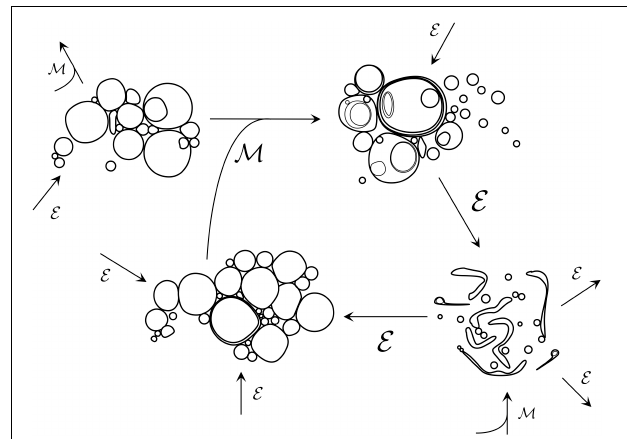
FIGURE 1 | Early prebiotic chemistry would have likely entailed diverse populations of low complexity colloidal systems, engaging in myriads of aggregative/competitive interactions and transformations. Environmental events ε such as changes in external osmolarity, pH, ionic concentrations, temperature, and local fluid flow conditions would drive fluctuations in the composition of populations and could also scaffold primitive division cycles. In parallel, population mixing events M would act to re-distribute and combine individuals from different populations via fusion. At this ‘messy’ stage of protocellular development, lipid vesicle populations would likely have been highly heterogeneous in terms of size, membrane composition, trapped internal molecules and lamellarity of individuals, with many individuals containing internal compartments nested in complex ways. Vesicle breakage and resealing would have been highly prevalent at this stage,